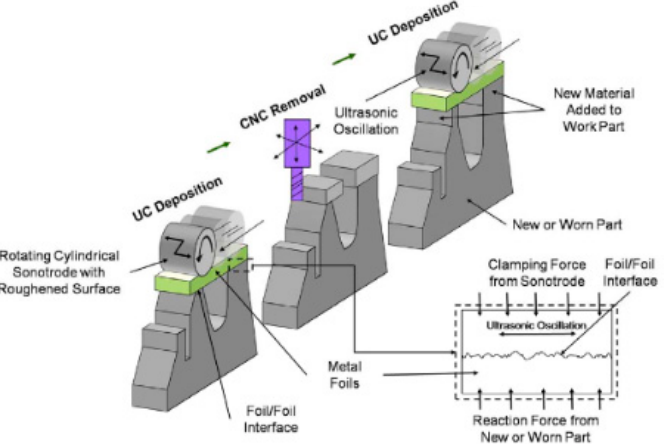
Figure 3. Representative image of the UAM process. Reproduced from [47]. Creative Commons CC BY license: https://creativecommons.org/licenses/by-nc-nd/4.0/; Accessed on 21 October 2022.